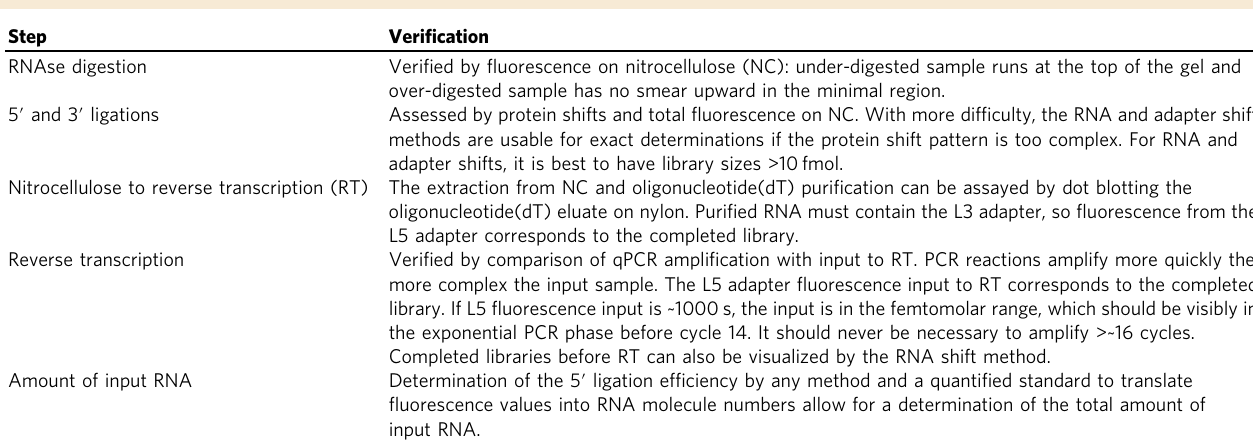
Fig. 2 The easyCLIP protocol. a easyCLIP schematic. b Diagrams of the 5 ′ and 3 ′ adapters with IR680 dye (LI-COR) and IR800-CW dye, respectively. c A nitrocellulose membrane representing the gel in panel ( a ), in which CLIP libraries produced for the protein hnRNP C are visualized by the dyes on the adapters, the 5 ′ in red and the 3 ′ in green. The size of uncross-linked hnRNP C noted at left. “ Larger complexes ” contain ligated adapter and hnRNP C protein; they likely re fl ect the presence of additional proteins, but their exact nature is unknown. The experiment was performed three times with similar results. d Spearman ’ ρ values for reads per gene from replicates of 11 RBPs, excluding RPL5 as it has only one de fi nitive target RNA (5S rRNA). Endogenous hnRNP C, RBFOX2, and FBL were immunopuri fi ed, HA-PCBP1 was stably integrated, and the others were transiently expressed as HA-tagged forms. PCBP1 was expressed in HCT116 cells and the others in 293Ts. e The most signi fi cant motif identi fi ed de novo by HOMER for the top mRNA peaks. Motif enrichment signi fi cance computed by HOMER (hypergeometric test with p value corrected for multiple testing). f The most signi fi cant motif identi fi ed de novo by HOMER for all peaks signi fi cantly enriched over randomly chosen non-RBPs. g Fraction of easyCLIP reads of the indicated RBP mapping to RNAs of the given ENSEMBL biotype. h Fraction of reads mapping to rRNA. i Fraction of reads across all RNA types (left) or across mRNA (right) that map to introns or exons. j Number of signi fi cantly enriched (FDR < 10 − 4 ) categories of RNAs, relative to randomly selected non-RBP controls. “ Mill. reads ” denotes represents one nucleotide in the normalized